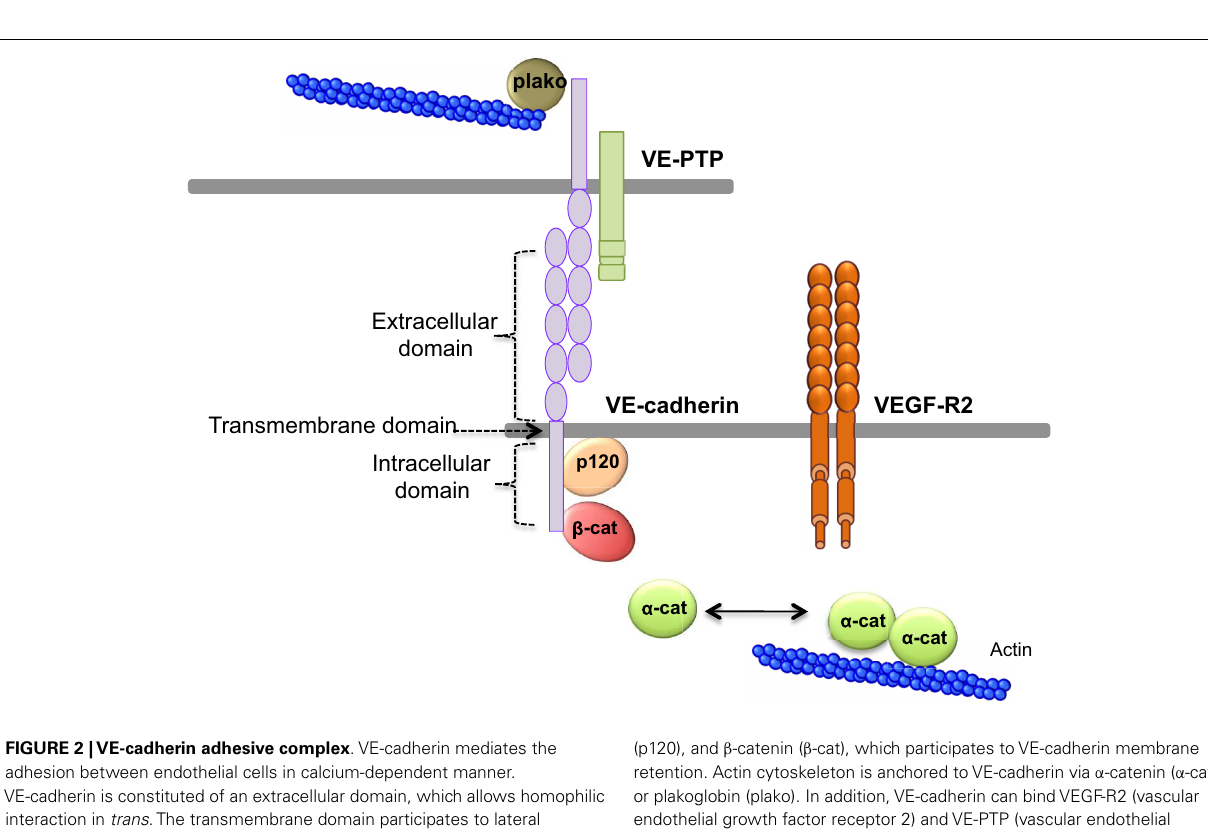
(p120), and β -catenin ( β -cat), which participates toVE-cadherin membrane retention. Actin cytoskeleton is anchored toVE-cadherin via α -catenin ( α -cat) or plakoglobin (plako). In addition,VE-cadherin can bindVEGF-R2 (vascular endothelial growth factor receptor 2) andVE-PTP (vascular endothelial phosphotyrosine